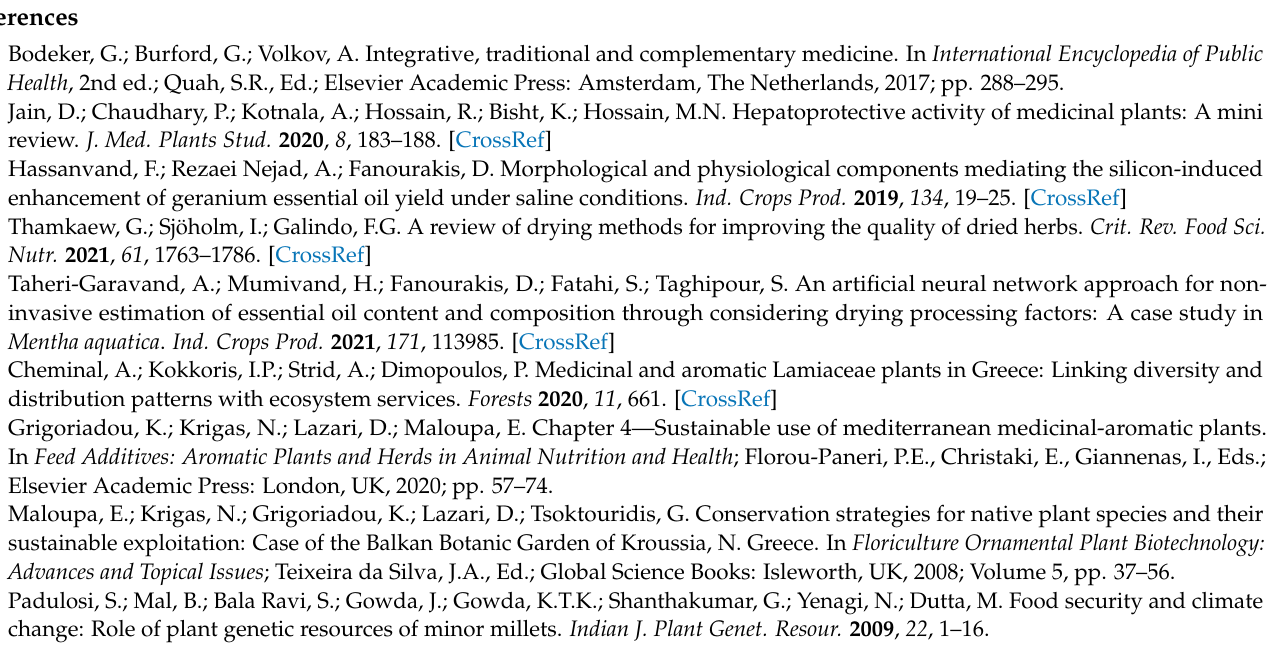
(C) full flowering (C) stage, Figure S4: Effect of fertilization through different (root/foliar) application methods on leaf b value of Origanum microphyllum at: (A) vegetation; (B) early flowering; (C) full flowering (C) stage, Table S1: Product details of purchased fertilizers used in the pilot cultivation of Origanum microphyllum in Heraklion, Crete, Greece, Table S2: Experimental field soil properties of the research garden of the Hellenic Mediterranean University used for the fertilization trials on Origanum